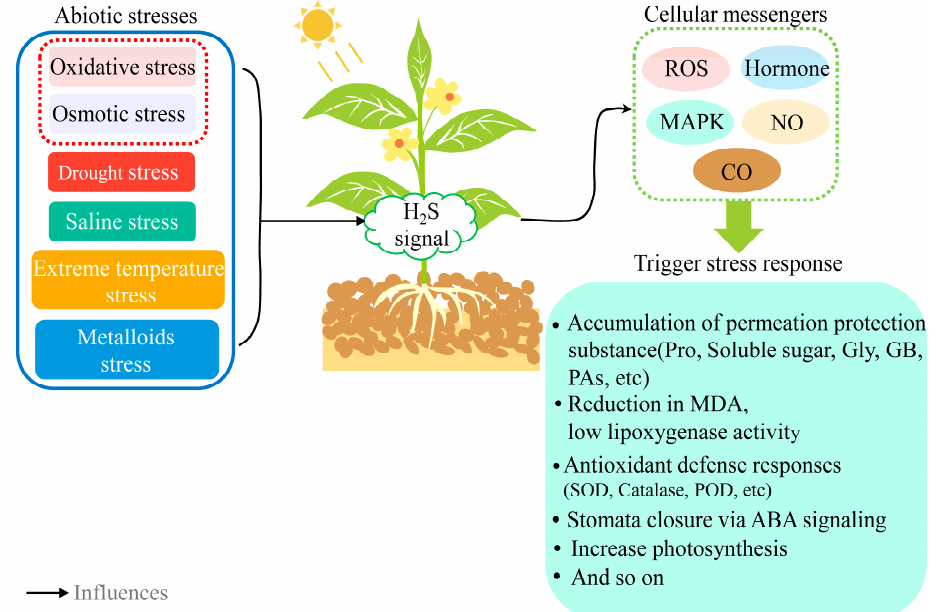
Figure 5. The effect of H 2 S on plant stress tolerance. ABA (abscisic acid), CO (carbon monoxide), GB (glycine betaine), Gly (glycine), H 2 S (hydrogen sulfide), MAPK (mitogen-activated protein kinase), MDA (malondialdehyde), PAs (polyamines), POD (peroxidase), Pro (proline), ROS (reactive oxygen species), SOD (superoxide dismutase).